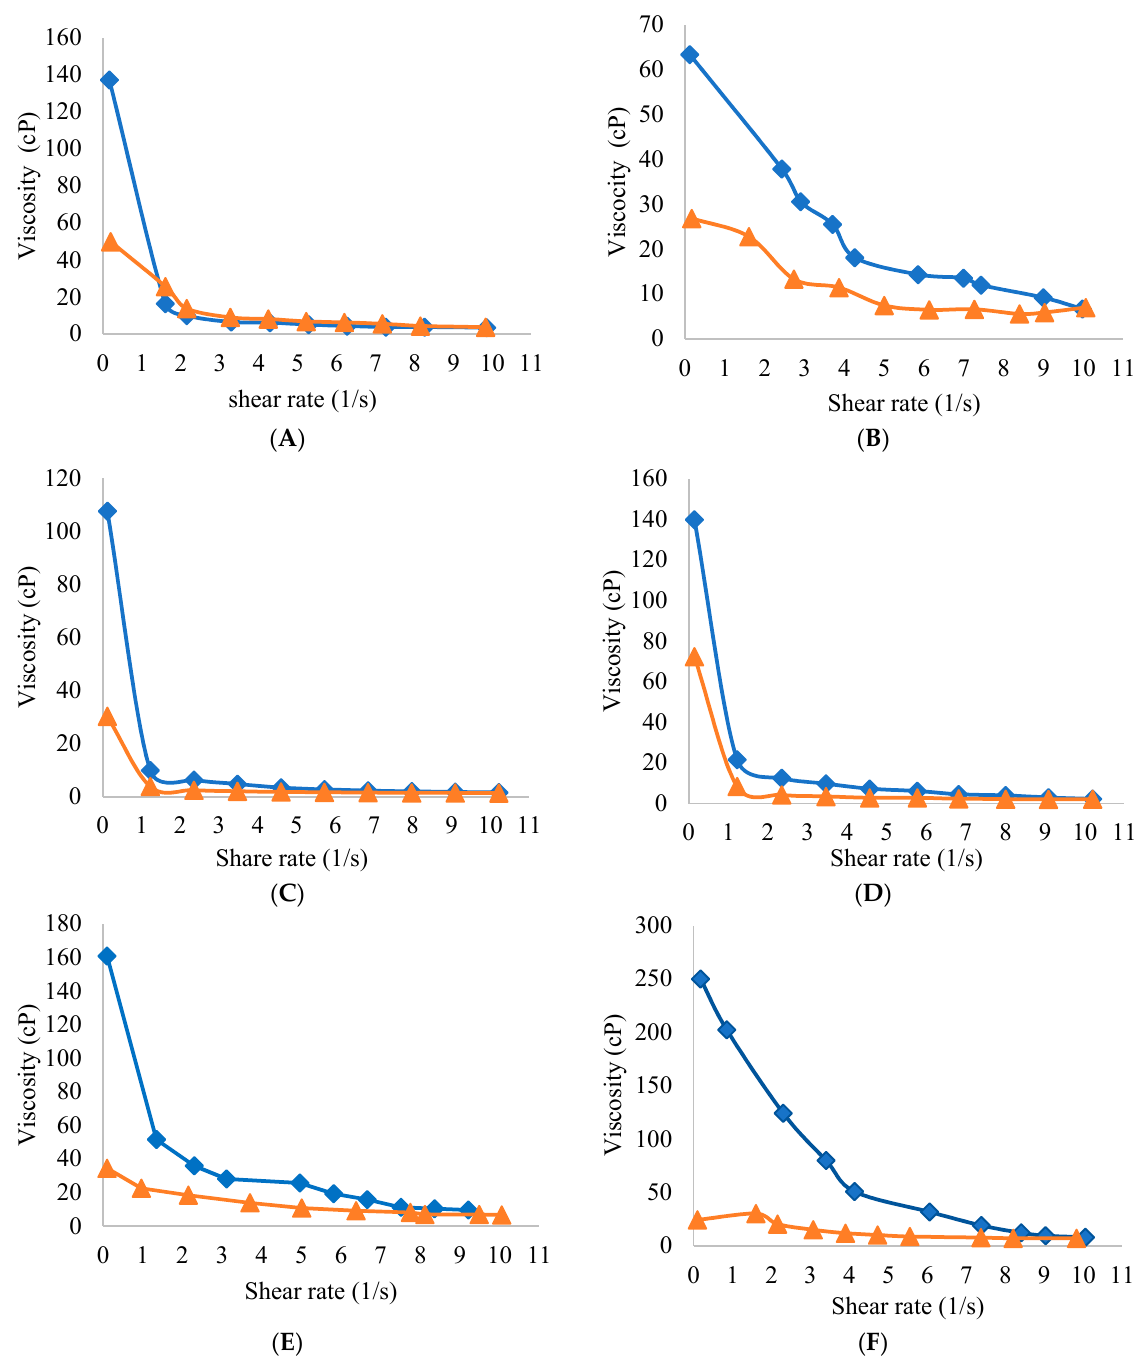
Figure 2. The apparent viscosity properties of yogurt samples: in straight/forward ( ♦ ); in opposite/reverse ( ▲ ). ( A ) FFY = full-fat yogurt produced from whole milk powder (WMP); ( B ) NFY = non-fat yogurt produced from skim milk powder (SMP); ( C ) NFYWPI-3 = SMP was replaced by 3% WPI; ( D ) NFYWP-5 = SMP was replaced by 5% WPI; ( E ) NFYWP-7 = SMP was replaced by 7% WPI; ( F ) NFYWP-9 = SMP was replaced by 9% WPI.